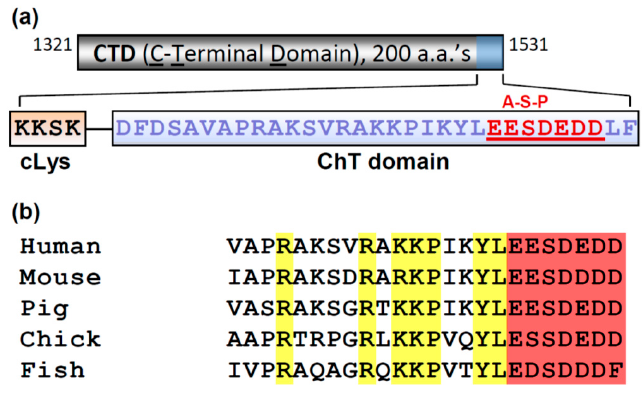
Figure 2. Components of the human Topo II α CTD: ( a ) 200 a.a. CTD (grey box); the last 31 residues define the Chromatin Tether (ChT) domain ( shaded blue ). ChT domain (blue box) with Acid-Patch nested serine motif (A-S-P; red) and the upstream cluster of Lysine (cLys) residues (orange box); ( b ) conserved ChT residues ( yellow ) of Topo II adjacent to the A-S-P motif ( red ).